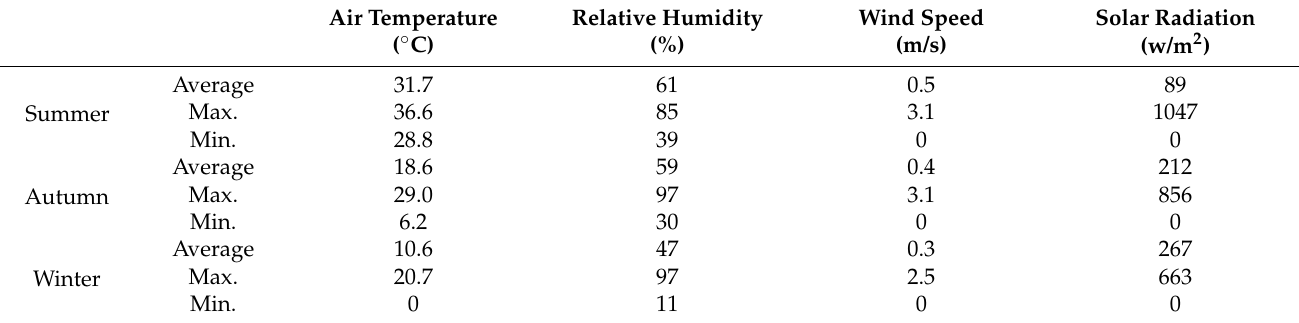
Table 2. The average/maximum/minimum air temperature, relative humidity, wind speed, and solar radiation, as measured in different seasons.